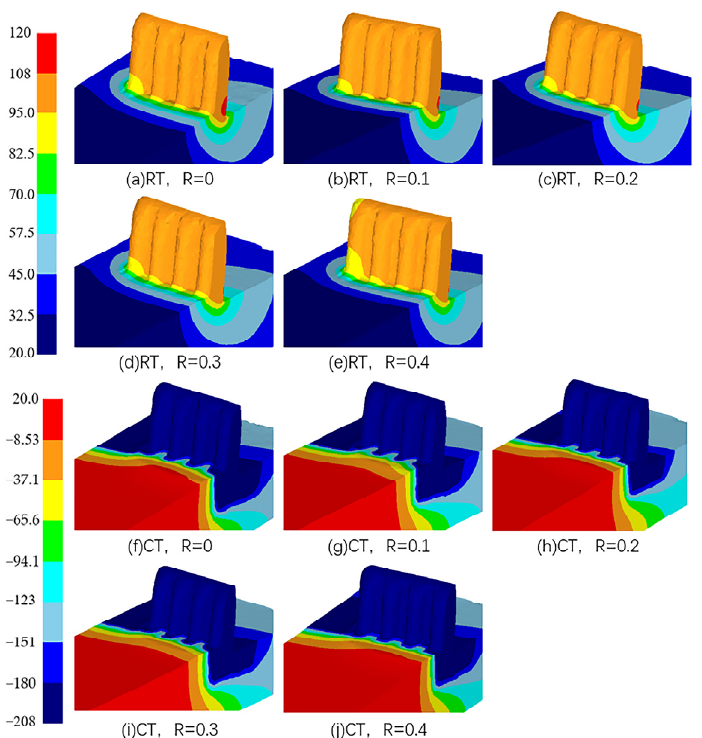
Figure 24. Temperature distribution of the fins under different conditions.